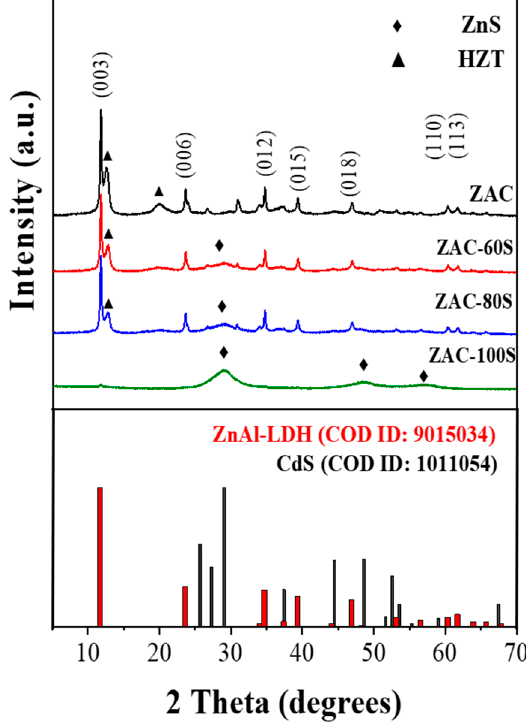
Figure 2. X-ray diffraction diffractograms of the ZnAl LDH samples modified with cadmium and Figure 2. X-ray Diffraction patterns of the ZnAl LDH samples modified with cadmium and sulfur. sulfur.